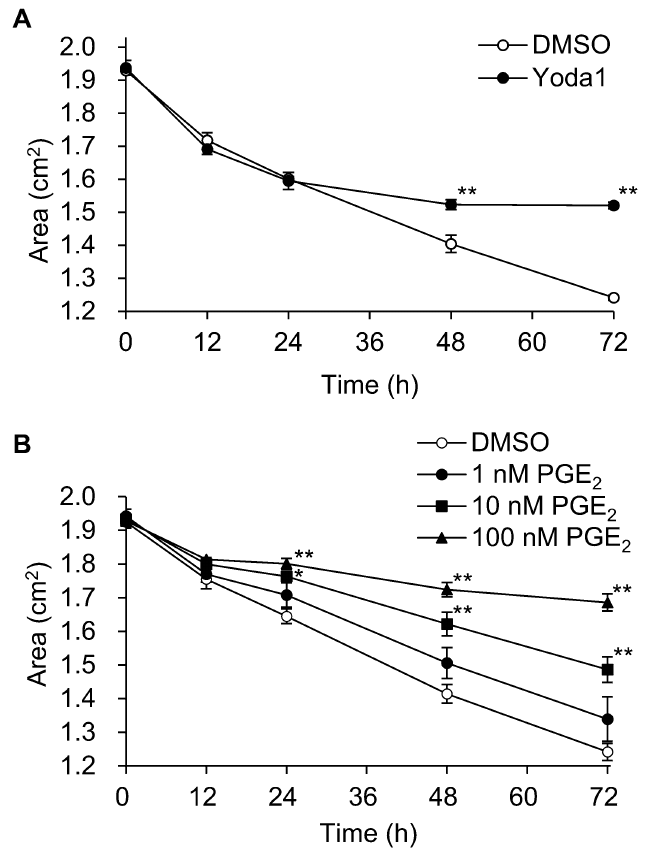
Figure 7. Effect of Yoda1 and PGE 2 on human trabecular meshwork cell-mediated collagen gel contraction. Changes in the collagen gel area in presence of Yoda1 ( A ) and PGE 2 ( B ). Data are expressed as means ± SE (n = 4 gels separated from 4 wells). * p < 0.05. ** p < 0.01, two-tailed Student’s t -test or Dunnett’s test.